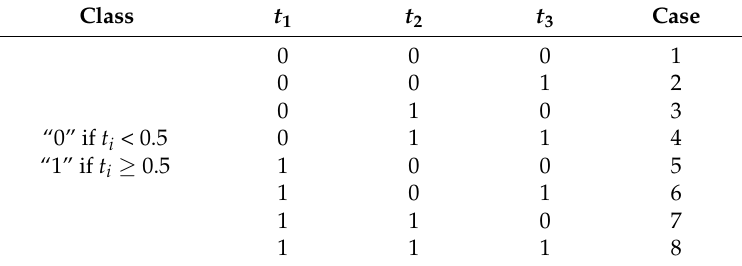
Table 4. Cases for the half-split of [0, 1).